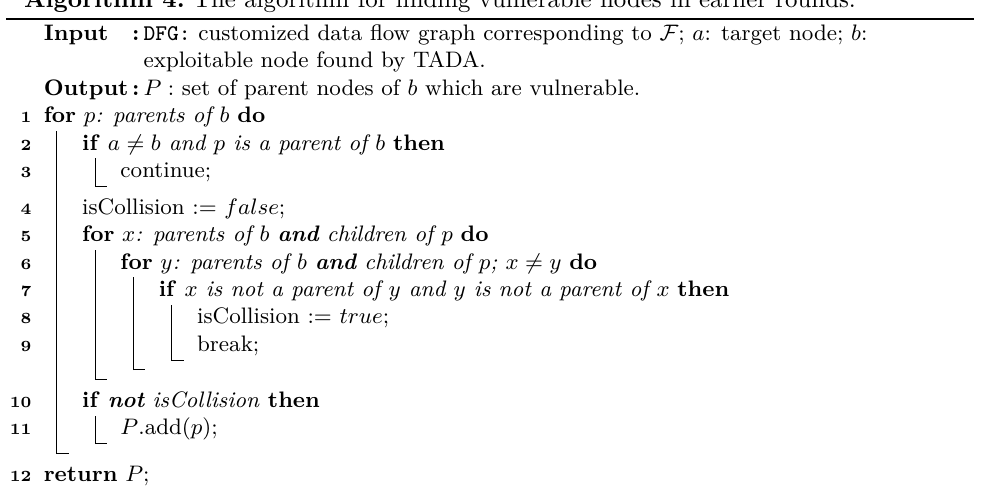
Algorithm 4: The algorithm for finding vulnerable nodes in earlier rounds.